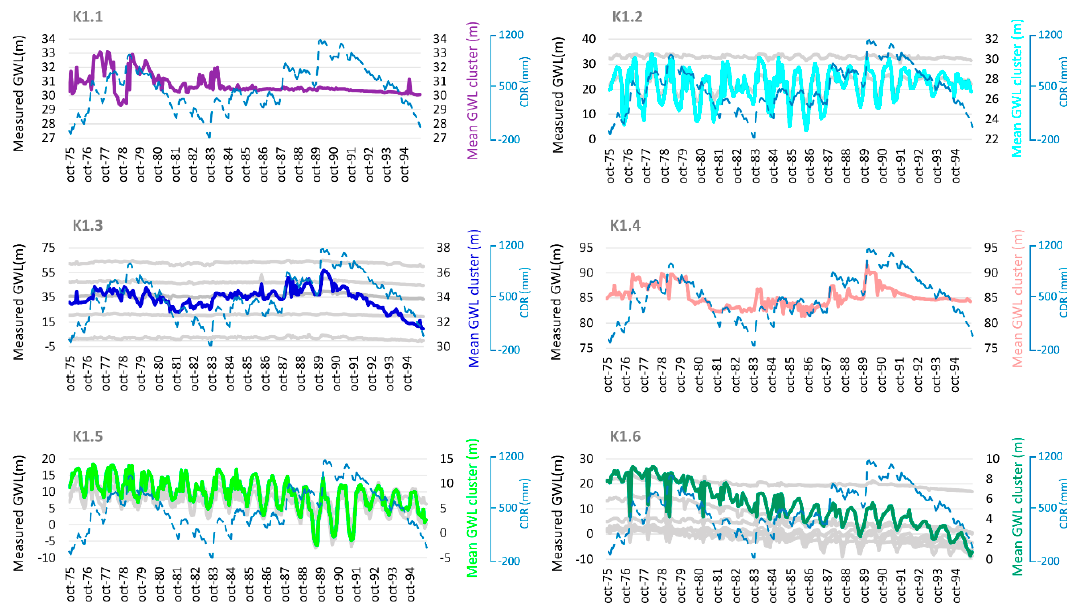
Figure 7. GWL series (grey lines), mean of the GWL cluster series (colored line) from October 1975 to September 1995 (first sub-period), classified by k-means clustering and cumulative deviation from the mean monthly rainfall (CDR).